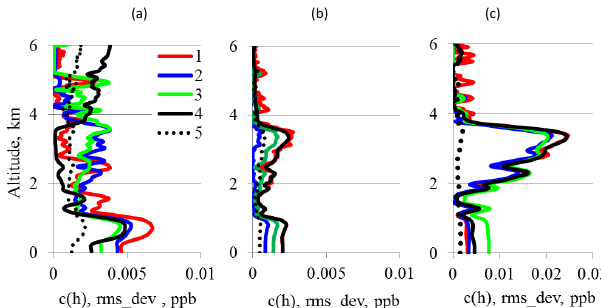
Figure 7. PVC profiles, c k (h) , and their rms-deviations retrieved in response to disturbed data from of the München lidar, EARLI09 in- tercomparison campaign, 14:30–15:30UTC, 25 May 2009, Leipzig, Germany: (a) – fine, (b) – coarse spherical, (c) – coarse non- spherical modes; 4 – for the original signal, 1–3 – for disturbed signals; 5 –